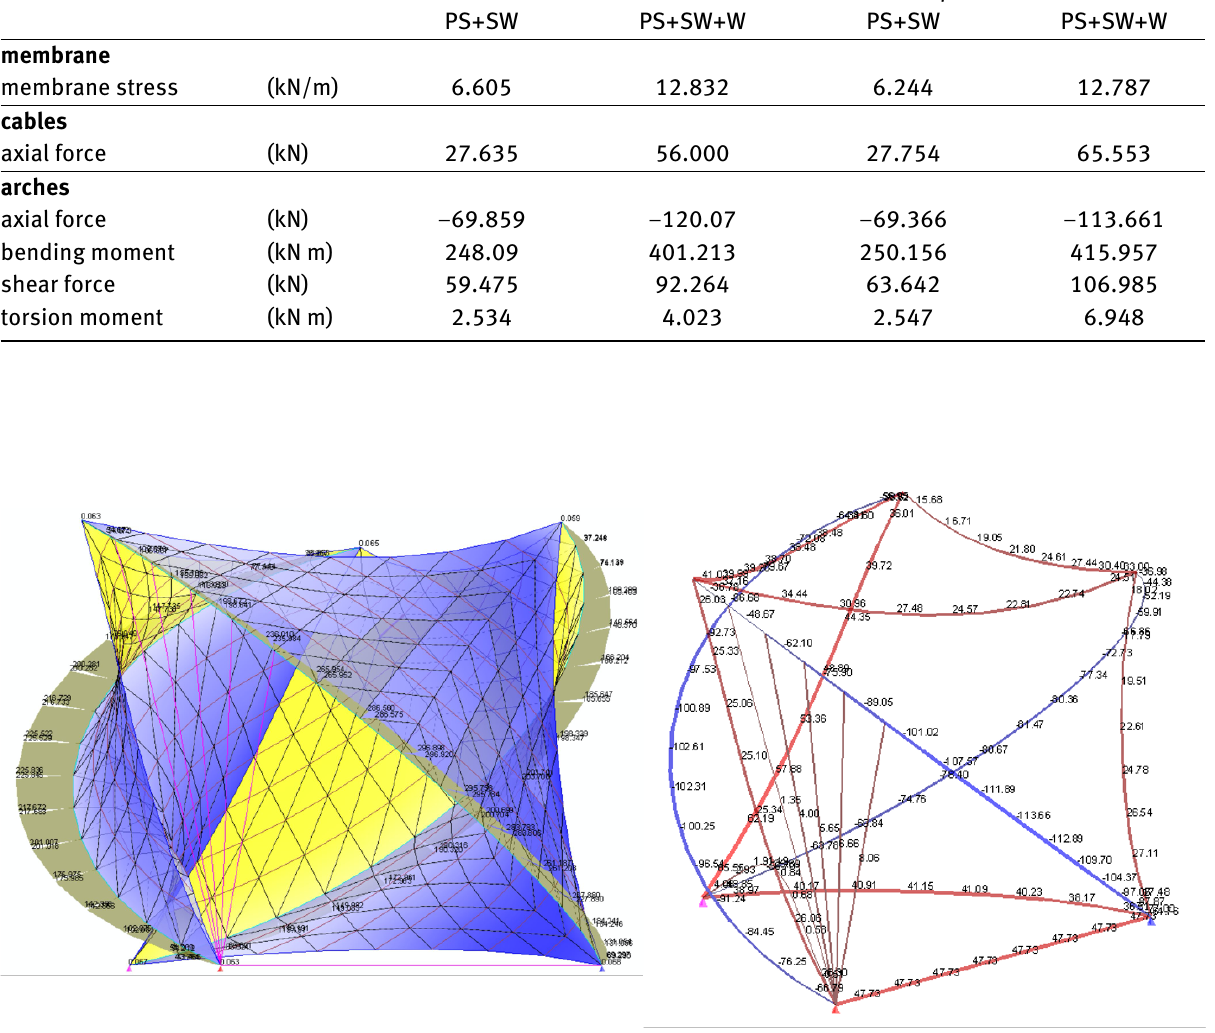
Figure 7: Bending moments of the arches, in kNm (left) and axial forces of cables and arches, in kN (right), at the equilibrium configuration under ULS with self-weight, prestress, and wind